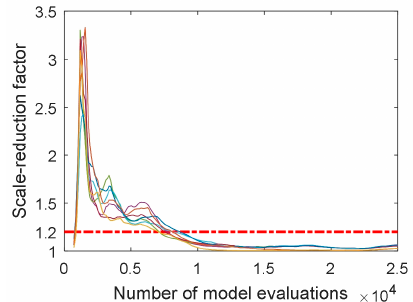
Figure 10. Evolution of the scale reduction factor for the seven estimation parameters.